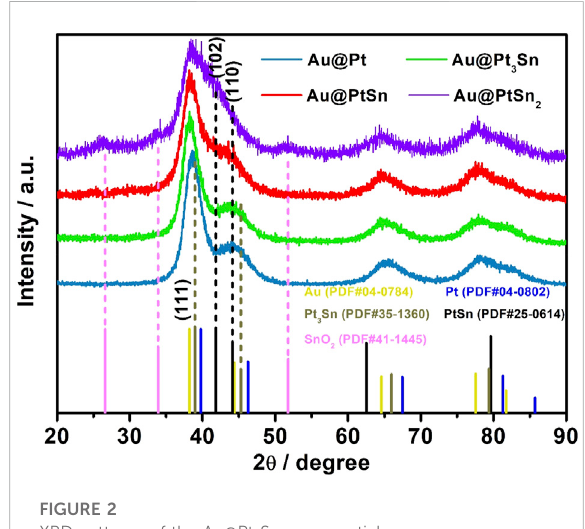
XRD patterns of the Au@Pt x Sn y